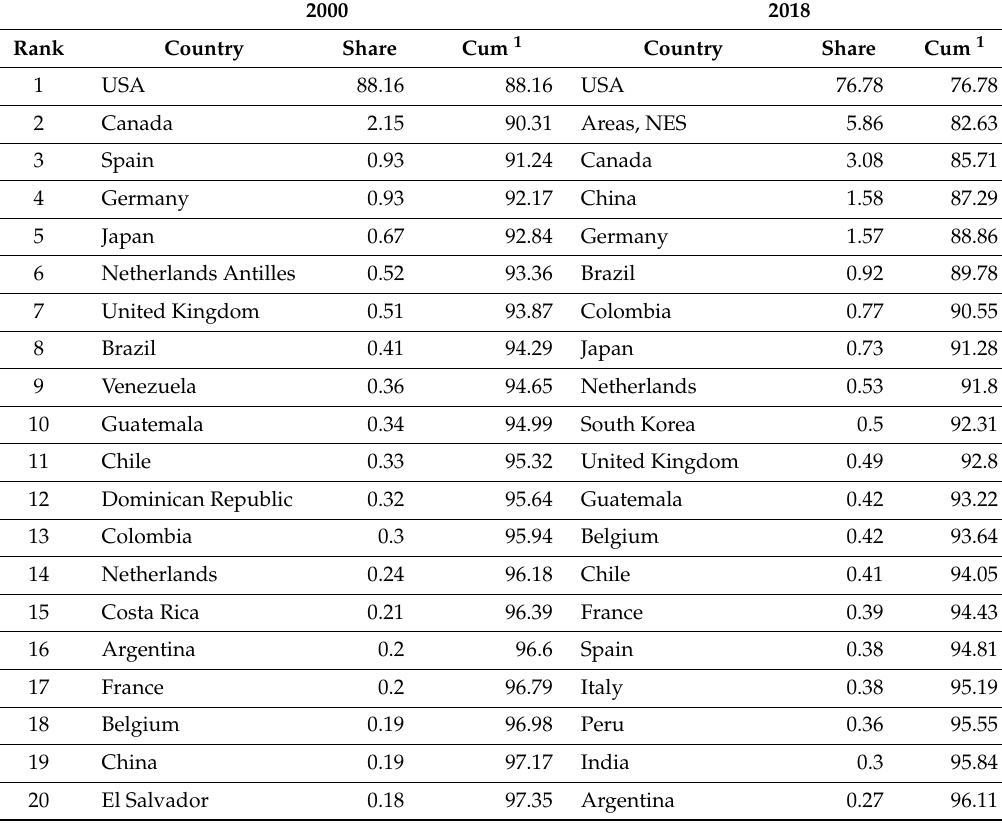
Table 8. Export Intensity Index: Mexico 2000–2018.